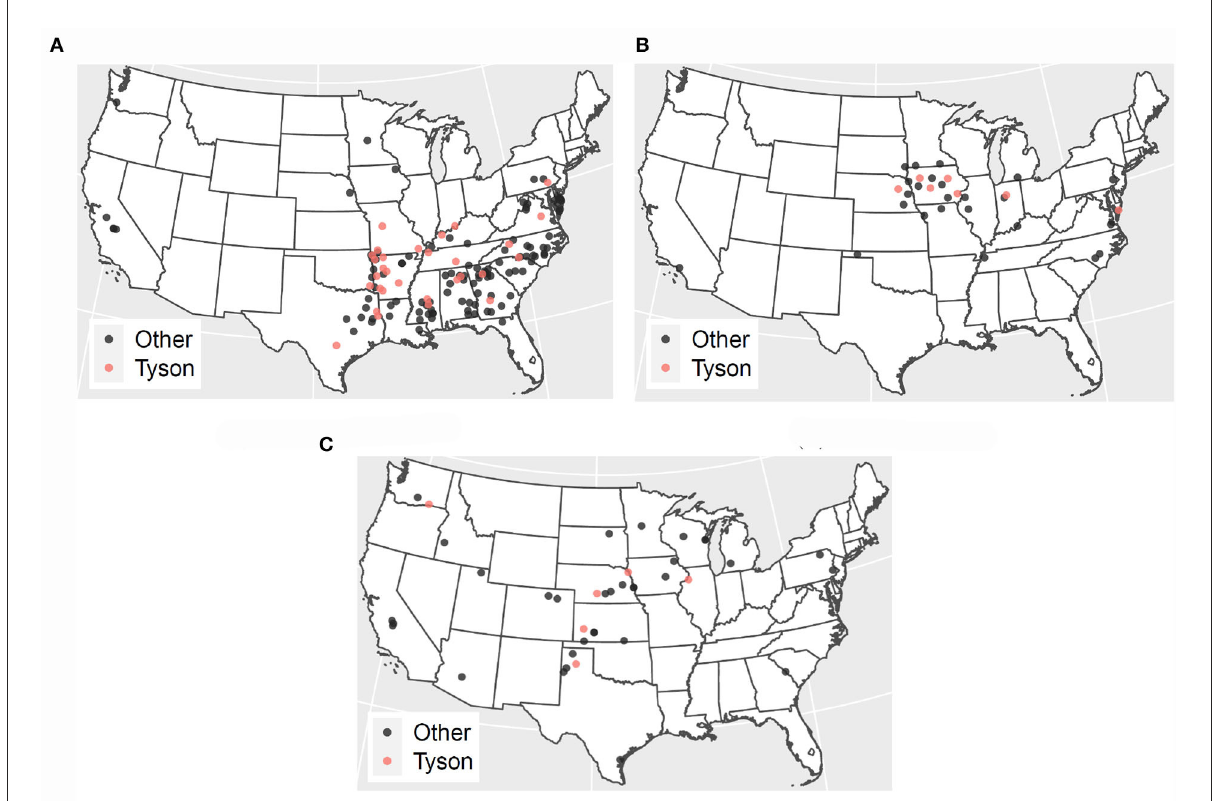
FIGURE1 Tyson and Non-Tyson Meatpacking locations. Figure shows the location of major Tyson and non-Tyson chicken (A) , pork (B) , and beef (C) processing plants from USDA Food Safety Inspection Service (FSIS, 2020). These data include kill plants (i.e., processing plants that slaughter animals) and not plants that are solely responsible for further